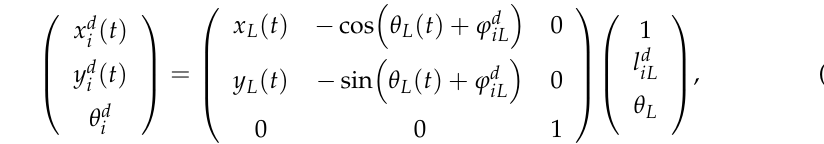
quantities of the leader robot as x L , y L and θ L . Then the ideal state quantities of the follower robot can be expressed as Equation (20).